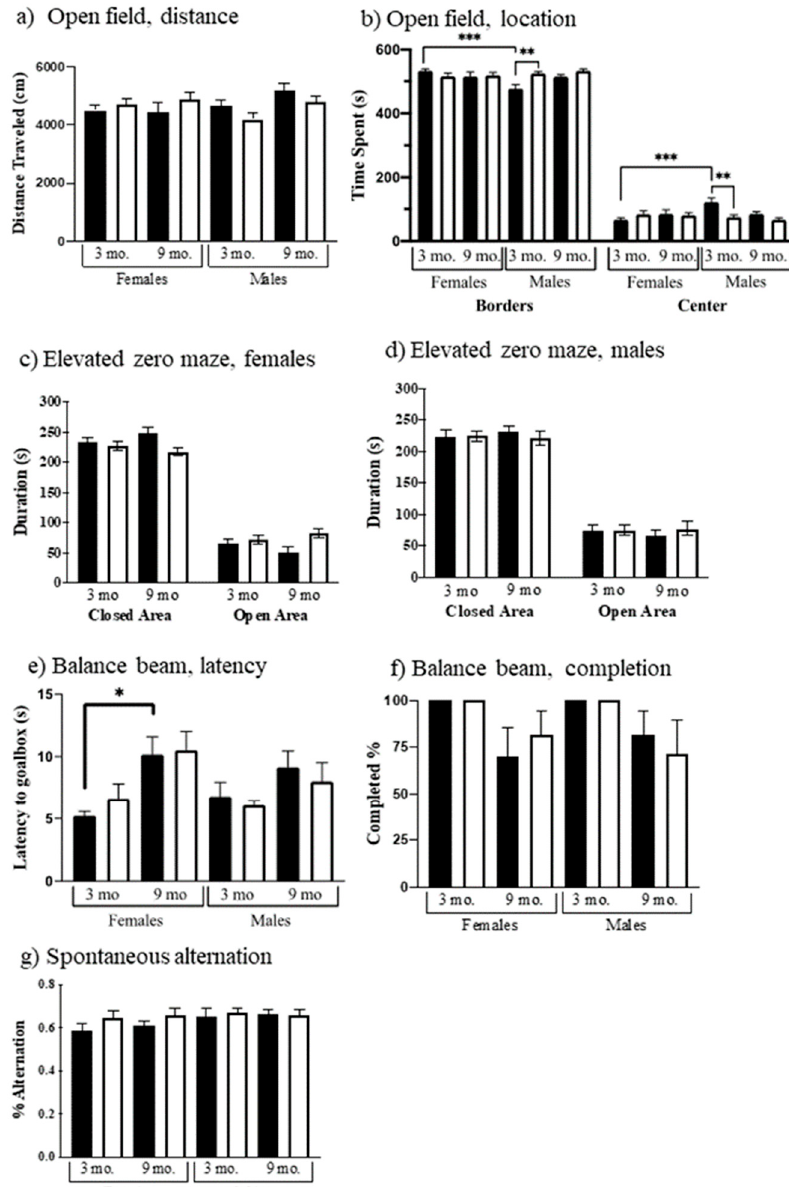
Figure 2. Performance in basic behaviors. Black bars, control; white bars, Dp10. Open field: ( a ) Total distance traveled, ( b ) Females and males, time at borders, and time in center. Elevated zero maze: ( c ) Females, open and closed areas; ( d ) Males, open and closed areas. Balance beam: ( e ) Time to reach goal box on narrowest beam; ( f ) % animals that completed the narrowest beam crossing. Spontaneous alternating Y-maze: ( g ) Females and males. Significant differences are indicated, p < 0.05, p < 0.01, p < 0.001 with *, **, and